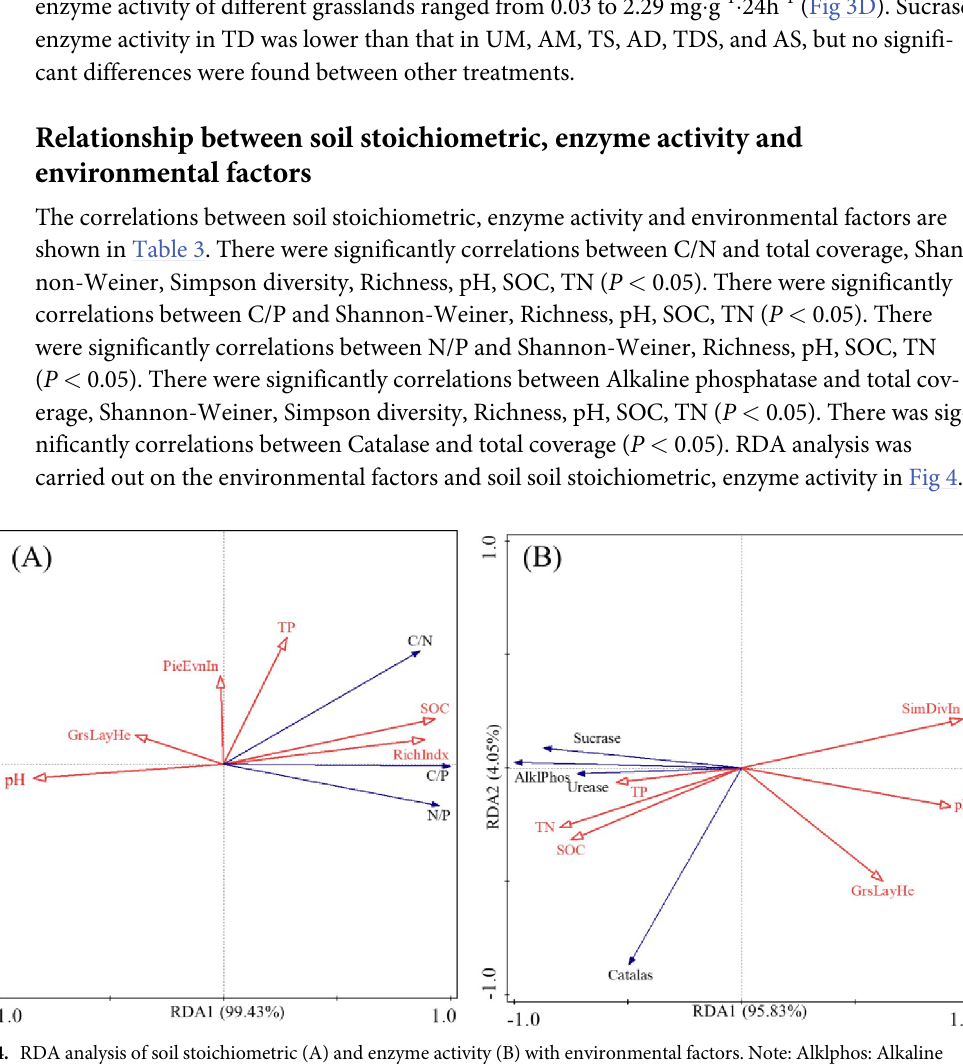
Fig 4. RDA analysis of soil stoichiometric (A) and enzyme activity (B) with environmental factors. Note: Alklphos: Alkaline phosphatase; SimDivIn: Simpson diversity index; Grsslayhe: Grass layer height; PieEvin: Pielou Evenness index; Richindex: Richness